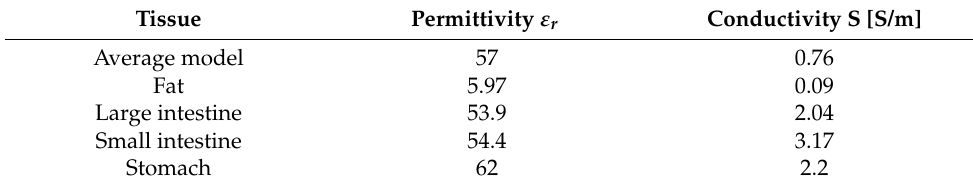
Table 2. Electrical properties of used tissues in antenna design and performance evaluation.